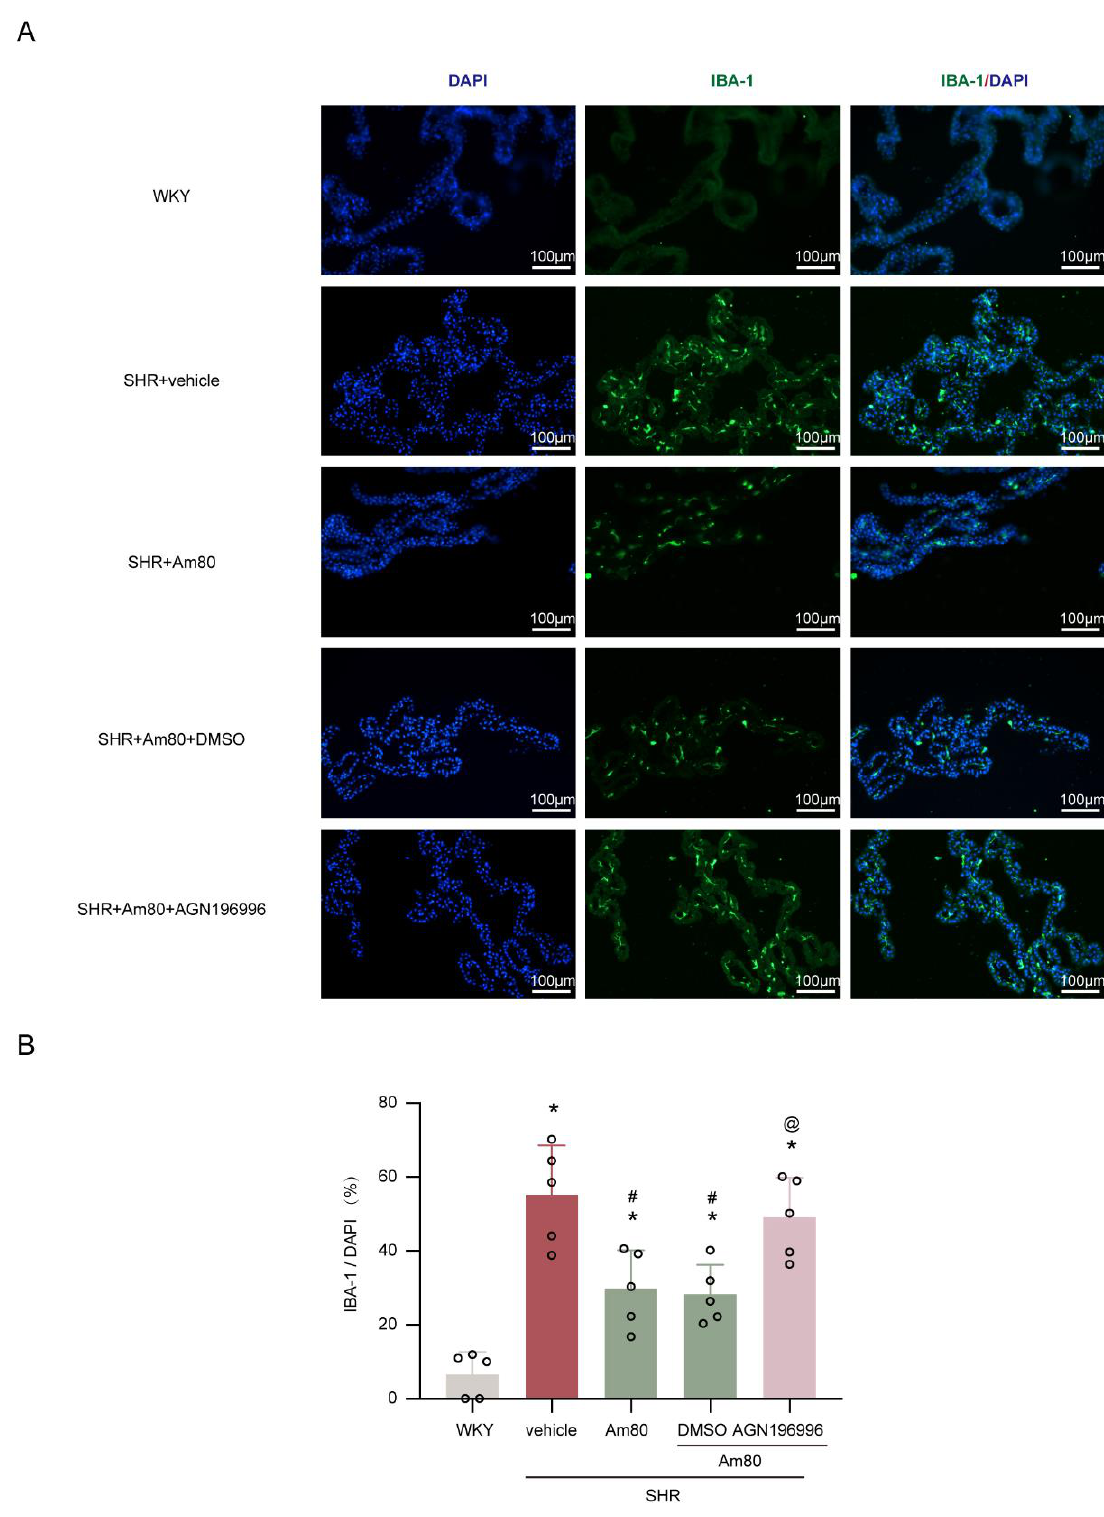
Figure 4. AGN196996 abolished the effects of Am80 on microglia/macrophage activation. ( A ) Examples of choroid plexus Iba-1 positive cells in rats at week 7. ( B ) Quantification of Iba-1 positive cells at week 7 ( n = 5). Scale bar, 100 µ m. * p < 0.05 versus WKY rats at week 7, # p < 0.05 vs. SHR + vehicle group, @ p < 0.05 vs. SHR + Am80 + DMSO group. Values are means ± SD.